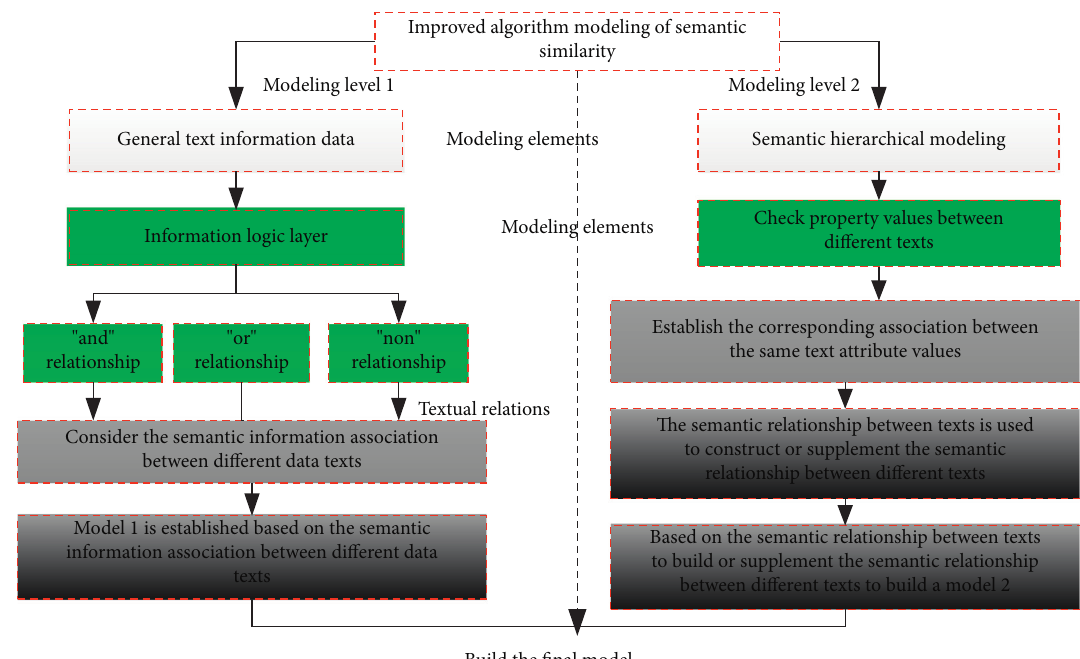
Figure 5: Flow chart of establishing the data information association model between